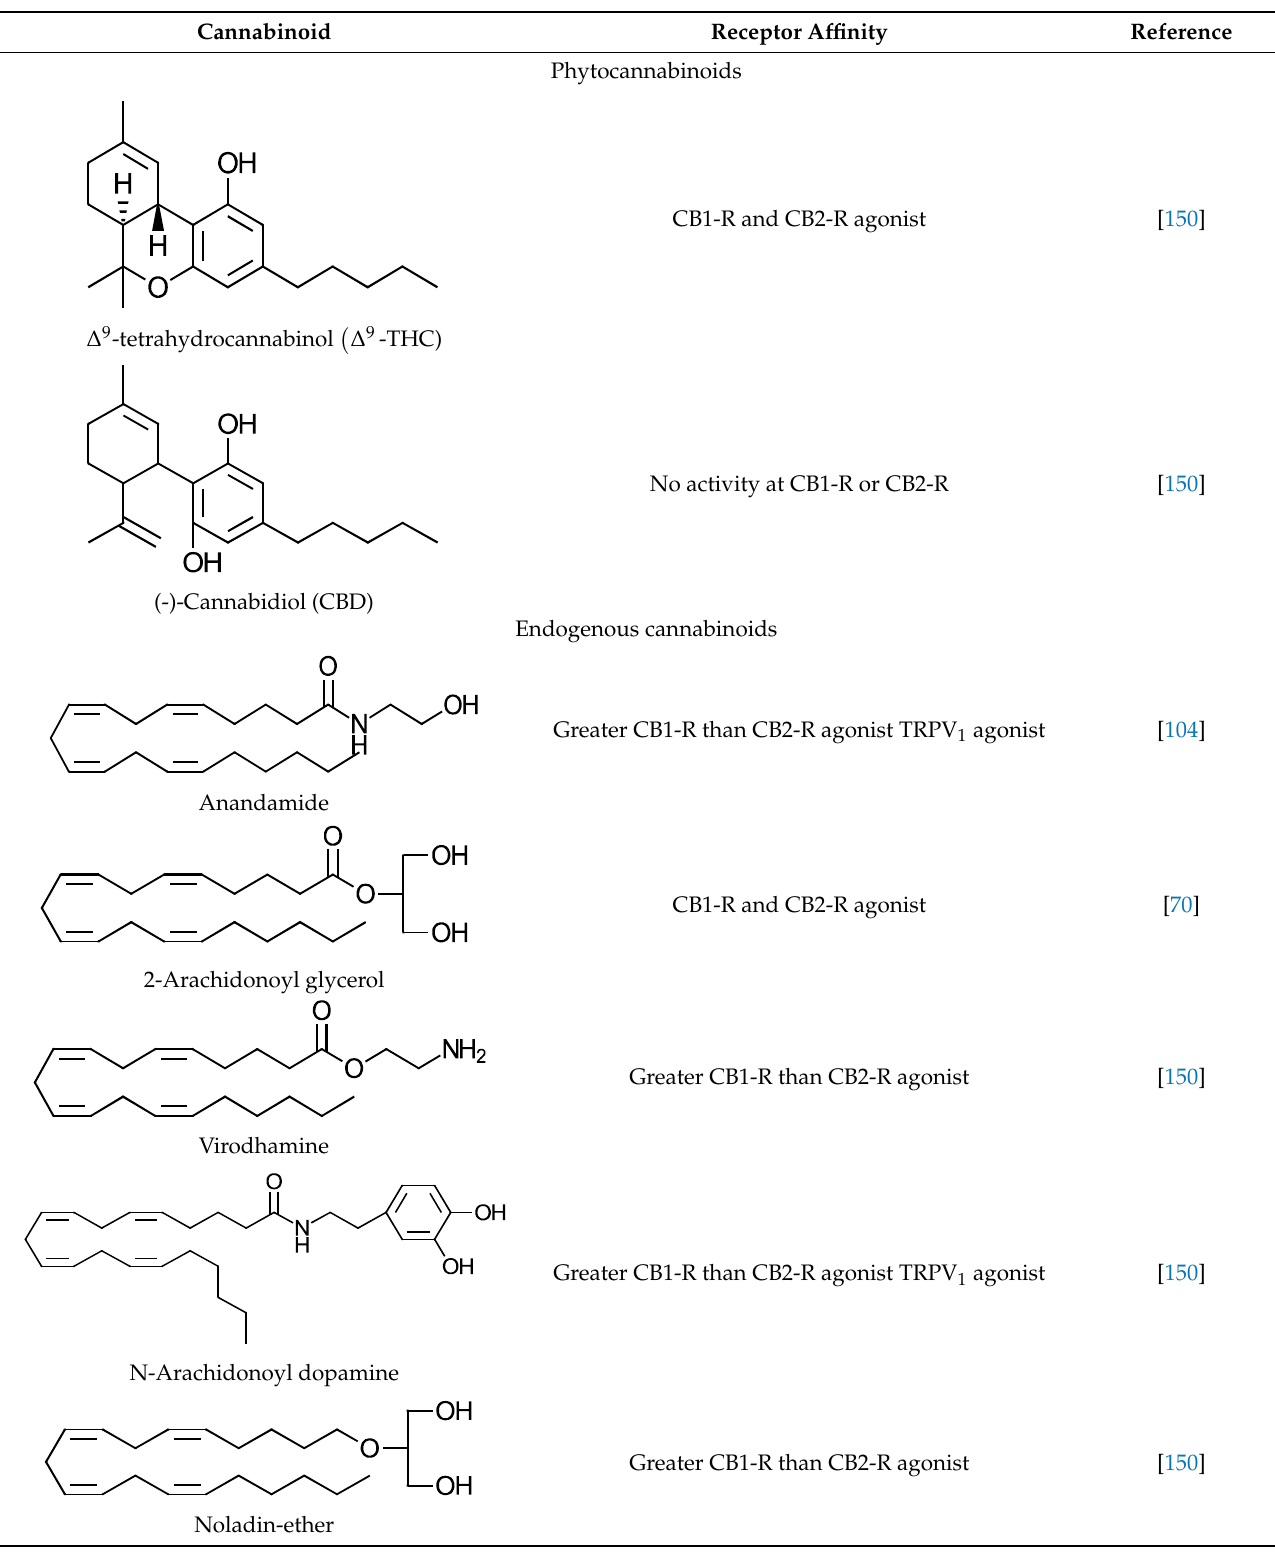
Table 3. Chemical structures of cannabinoids and their affinity to the CB receptors.